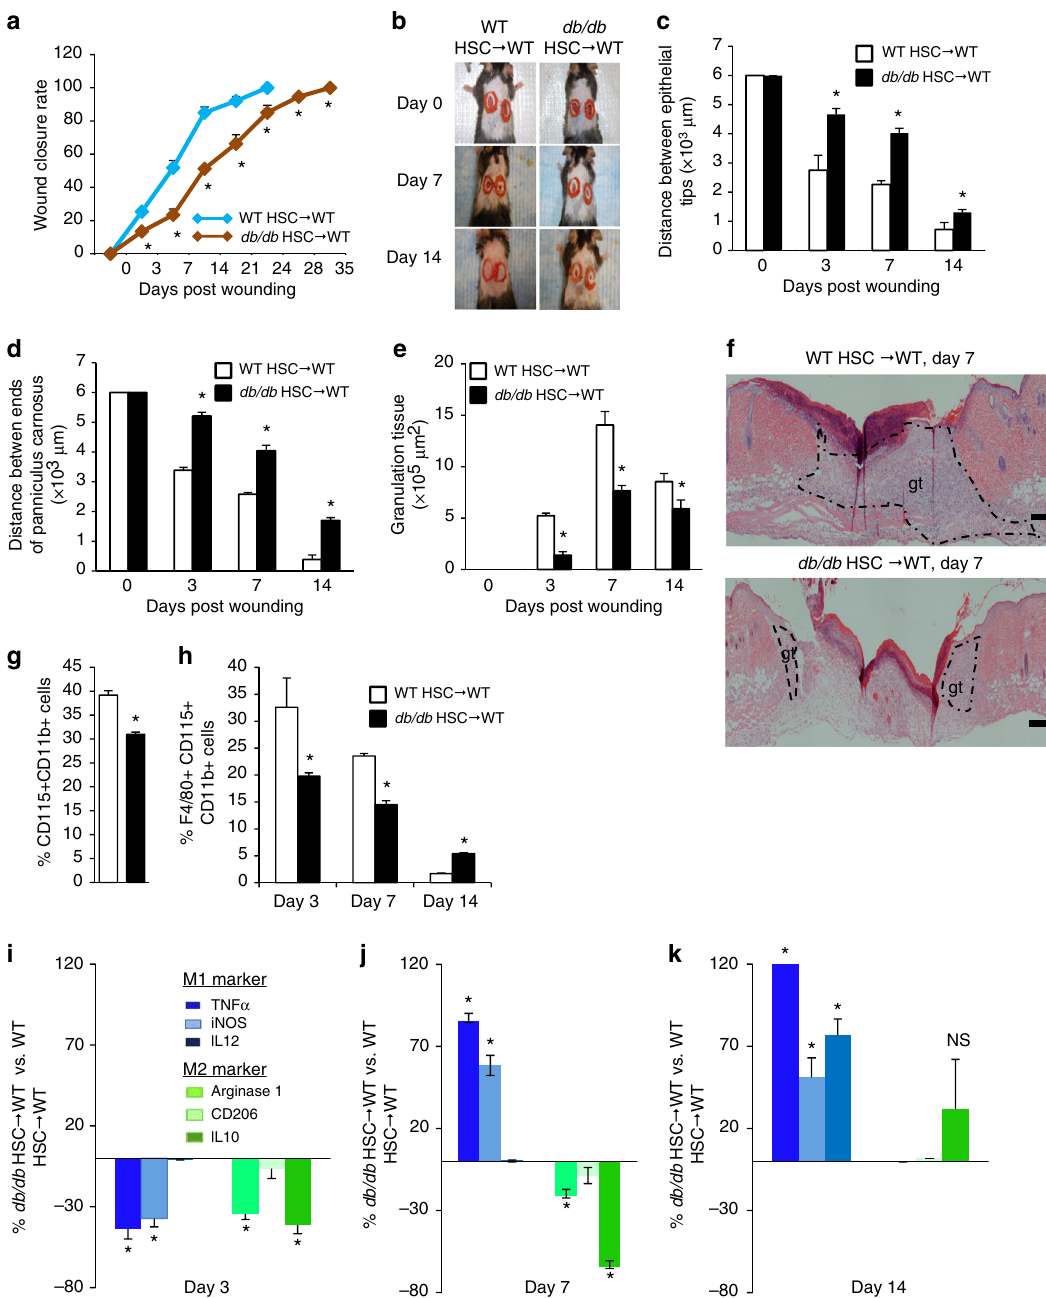
Fig. 3 Type 2 diabetes impairs wound healing and monocytes/macrophages in fi ltration. a , b Wound closure rate measurement and representative images ( n = 8, * p < 0.05 vs. WT HSC → WT). c – e Histological quanti fi cation of distance between epithelial tips/ends of panniculus carnosus and granulation tissue ( n = 4, * p < 0.05 vs. WT HSC → WT). f Representative H&E staining wound images, magni fi cation ×40. Scale bar, 100 μ m. gt, granulation tissue. g Quanti fi cation of monocytes concentration in bone marrow by fl ow cytometry ( n = 6, * p < 0.05 vs. WT HSC → WT). h Quanti fi cation of macrophage concentration in the cutaneous wounds by fl ow cytometry ( n = 6, * p < 0.05 vs. WT HSC → WT). i – k Quanti fi cation of M1/M2 polarization in cutaneous wounds by fl ow cytometry. ( n = 6, * p < 0.05 vs. WT HSC → WT). Results are expressed as means ± SEM. Two-tailed unpaired Student ’ s t test was